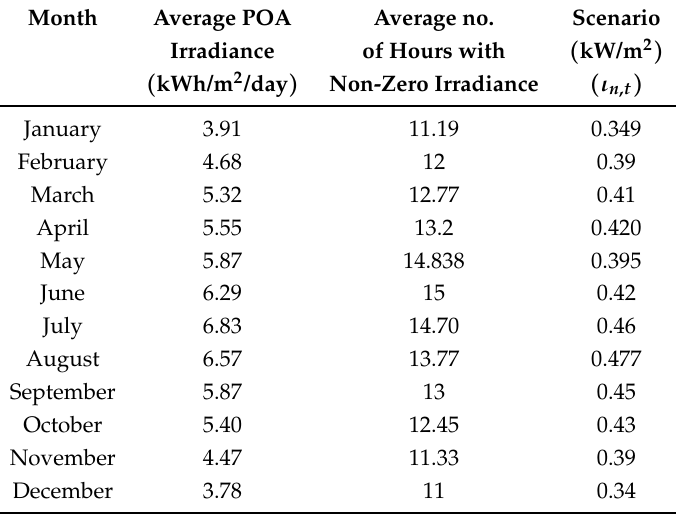
Table 5. Irradiance scenario